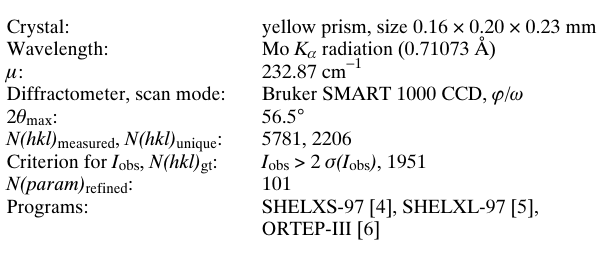
Table 1. Datacollection and handling.